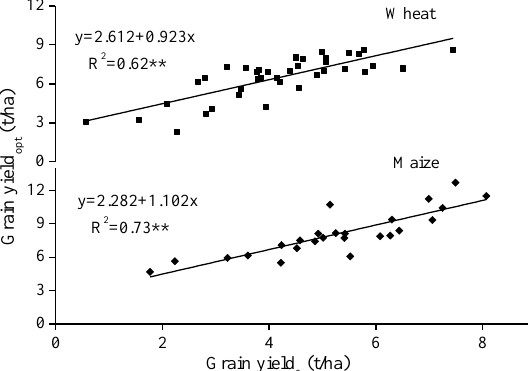
Figure 2. Correlation between N f.opt estimated using NRE ac (75%) and N f.opt measured using 3414 experiments with a quadratic curve fitting for wheat and maize. Note: ** indicates significance at 0.01 level; N f.opt is an economically optimal N rate; NRE ac is an apparent accumulated N recovery efficiency.